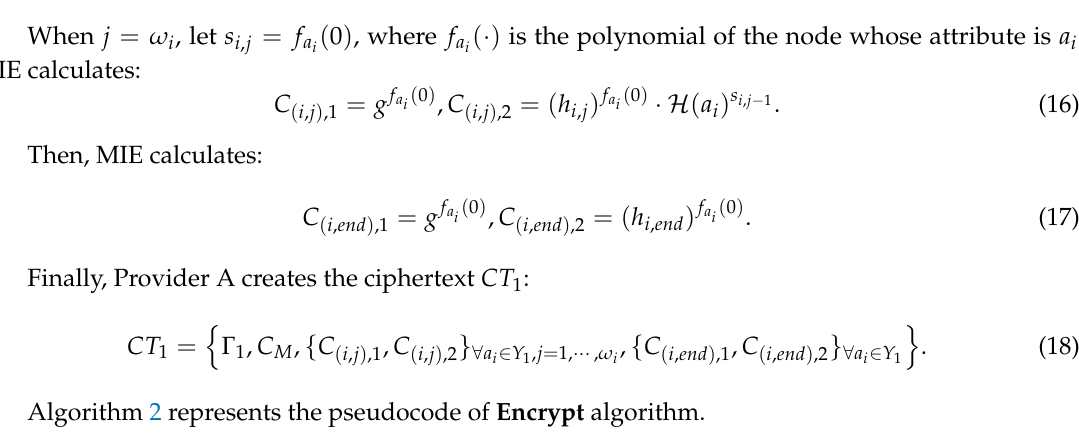
Algorithm 2 represents the pseudocode of Encrypt